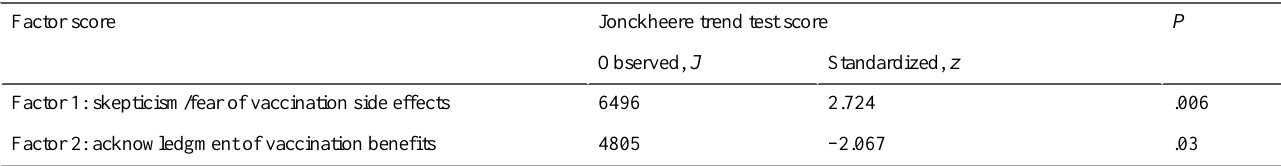
Table 3. Jonckheere’s trend test results for attitude factor